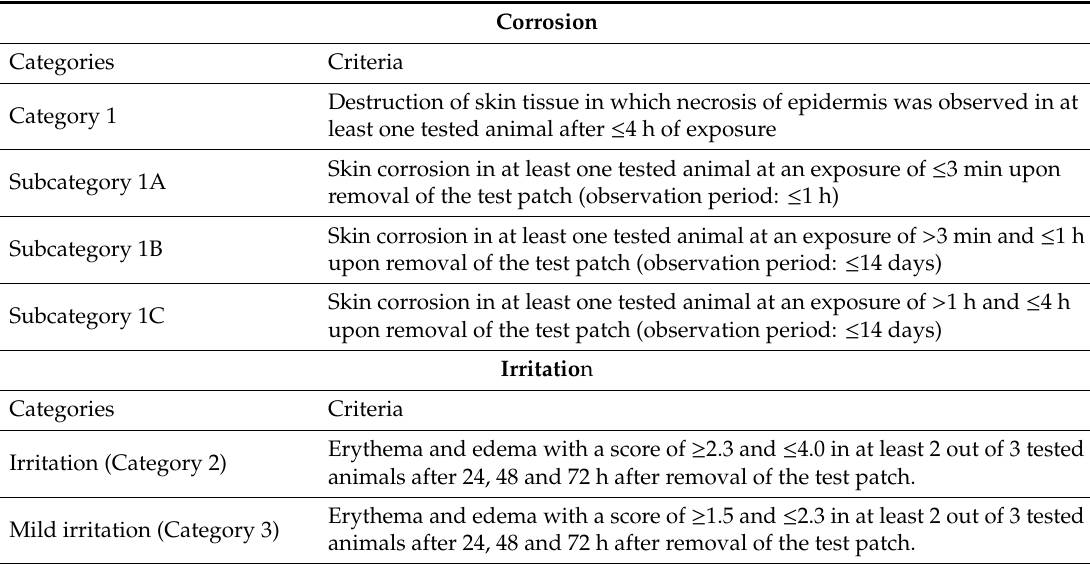
Table 6. Skin corrosion and irritation category and subcategories according to the Globally Harmonized System of Classification and Labelling Chemicals